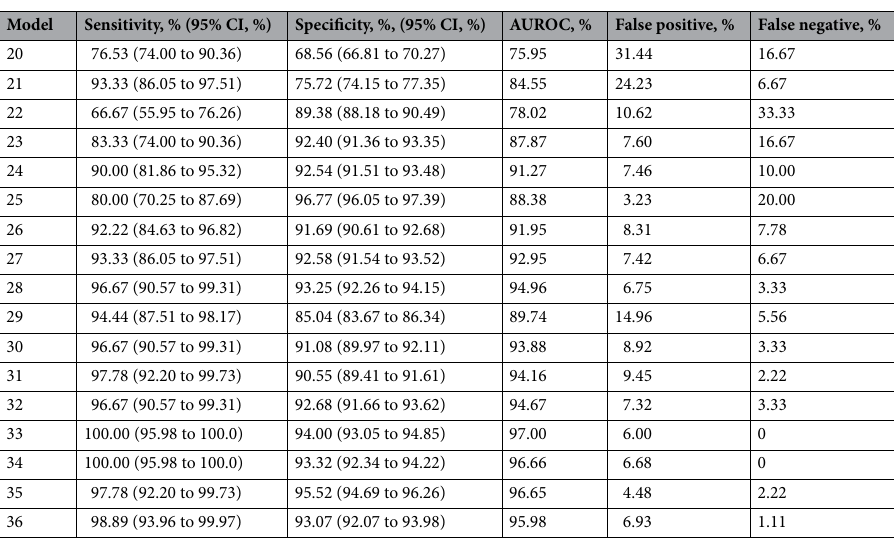
Table 1. Diagnostic performance of deep learning models. CI confidence interval, AUROC area under the receiver operating characteristic curve.